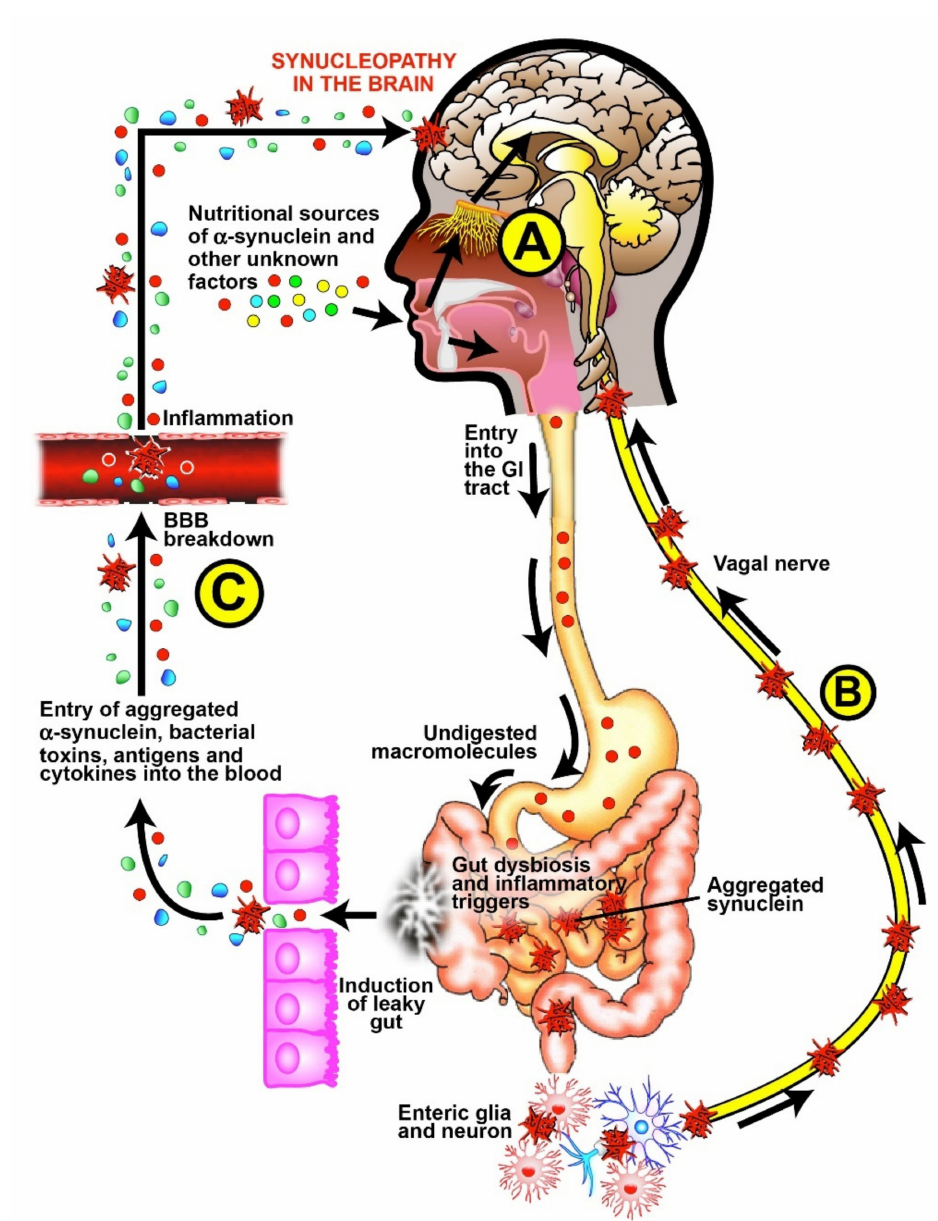
Figure 7. The triple-hit hypothesis of alpha-synucleopathy in the gut-brain axes of patients with Parkinson’s disease. Nutritional sources of aSN or cross-reactive nutritional peptides enter in the oral cavity. After chewing, some of those transformed substances may penetrate through the olfactory bud in the nasal cavity into the brain ( A ). The nutritional factors proceed from the oral cavity into the stomach and intestine. If improperly digested or modified, those nutritional substances may induce gut dysbiosis, enhance the production of inflammatory triggers and amyloidogenesis resulting in the aggregation of aSN. The aggregated aSN activates enterocytes/enteroendocrine/subepithelial dendritic cells, in close contact with the enteric glia cells and through the neurons, uptake the aSN aggregates and deliver them to the brain via the vagal nerve ( B ). The inflammatory mediators trigger leaky gut and enhance the entry of aggregated aSN and other macromolecules into the circulation, igniting further inflammation in the blood. Those molecules together induce breakdowns in the BBB, followed by the entry of the aggregated aSN and other molecules into the brain ( C ). Thus, the entry of aggregated aSN via the olfactory bulb, the enteric nerve, or broken gut and blood-brain barriers can result in synucleopathy and the formation of Lewy bodies in Parkinson’s